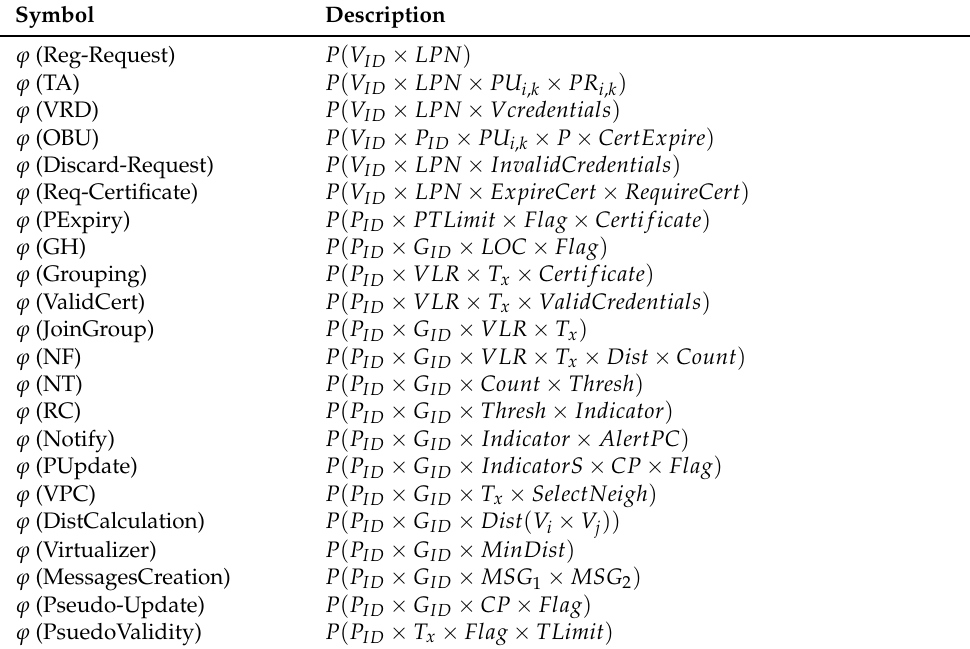
Table 3. Places used in HLPN for DGVP